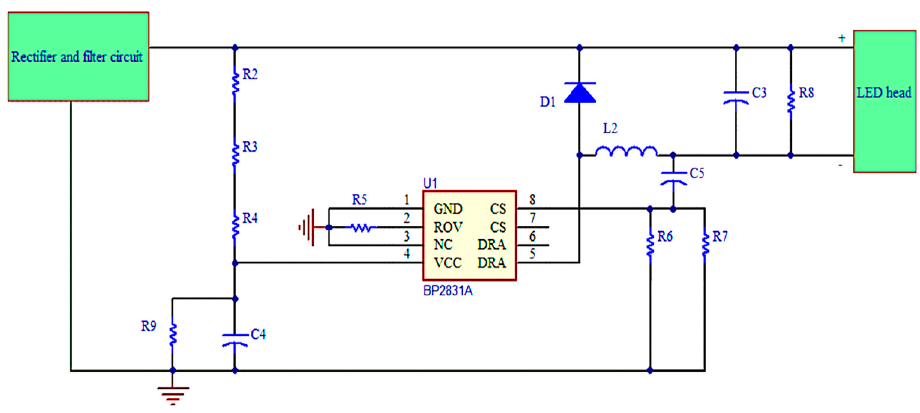
Figure 7. Current control circuit in the LED drive circuit (Sample A). Table 3. Specifications of IC BP2831A